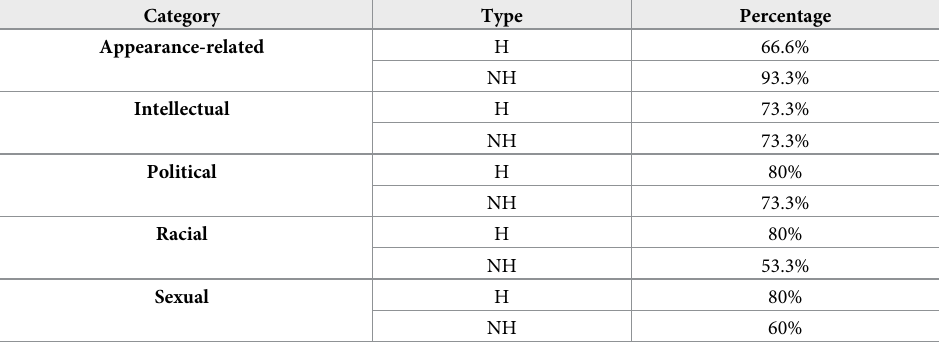
Table 5. Percentage of type-dependent of top-15 frequent words within each sub-corpus. H stands for the harassing corpus and NH stands for the non-harassing